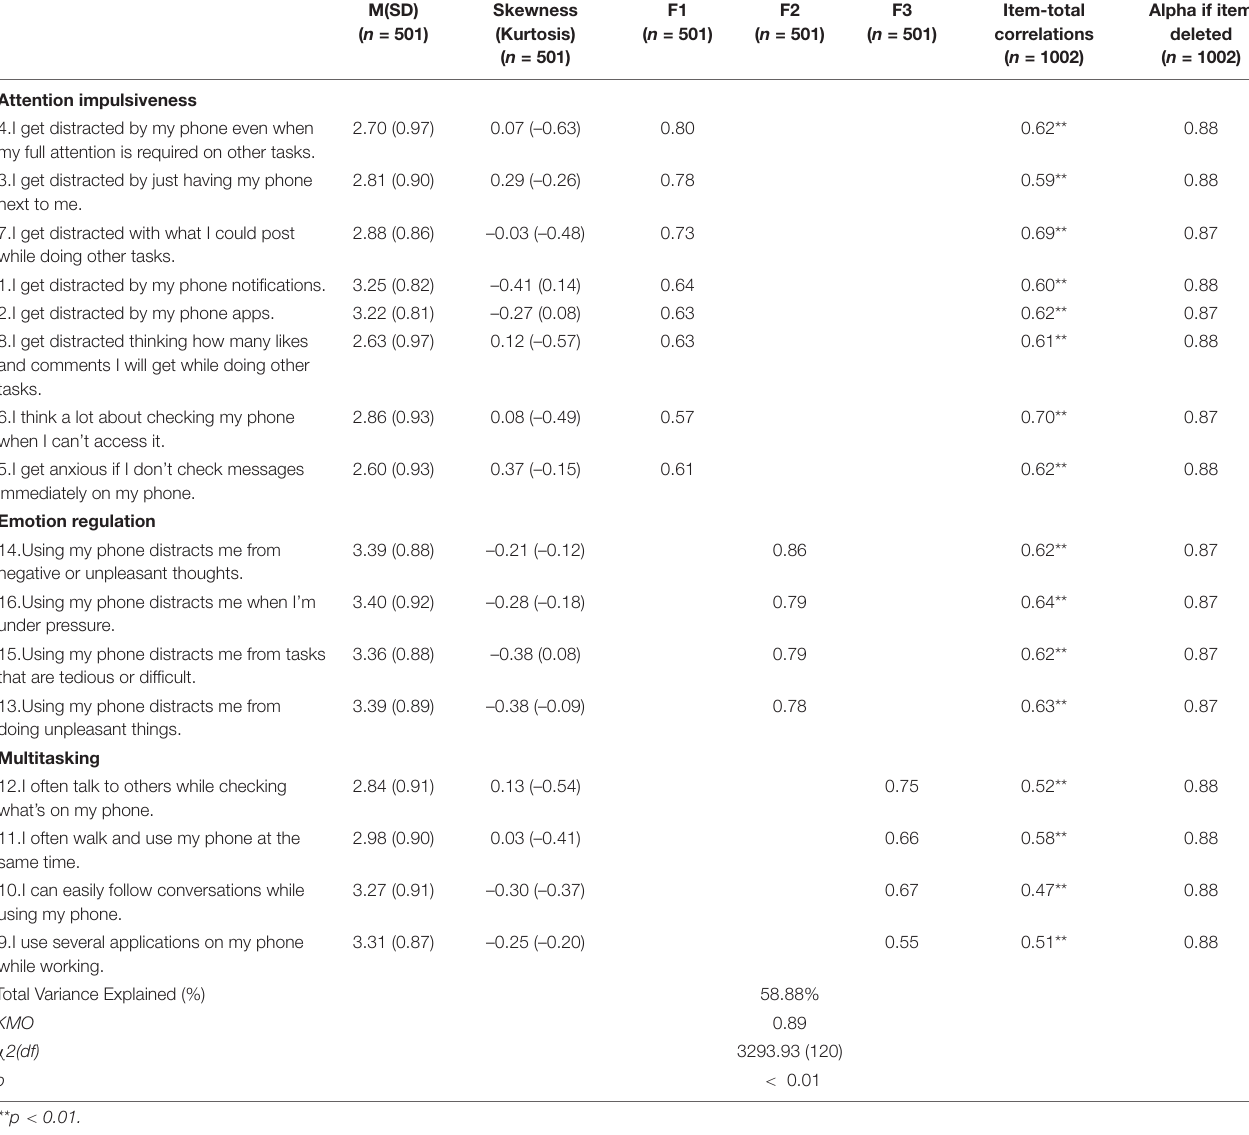
TABLE 2 | Factor loadings for the C-SDS items.